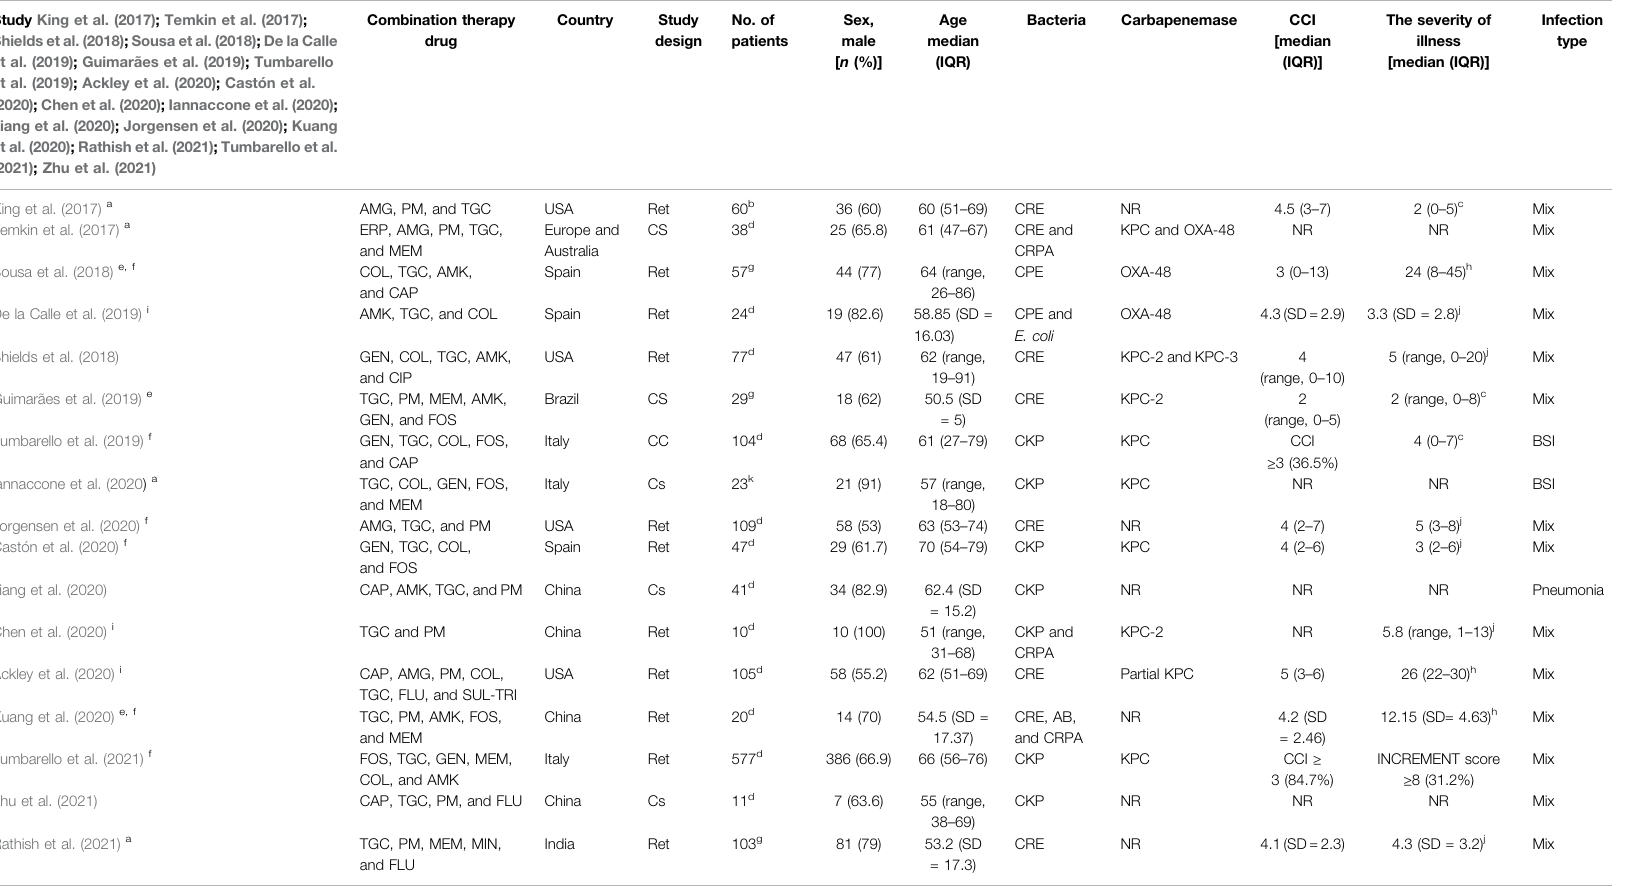
TABLE 1 | Characteristics of the 17 studies included in the